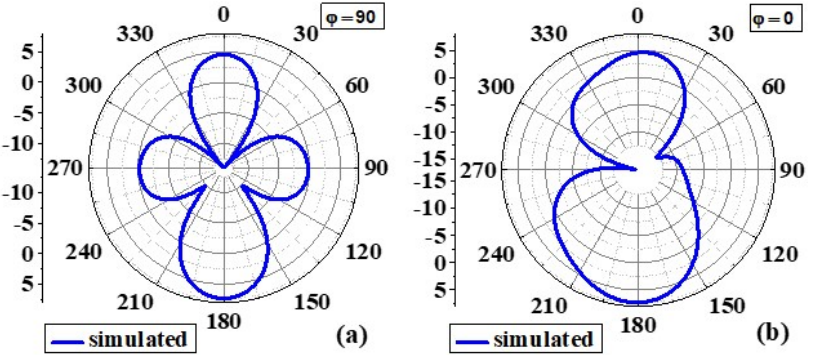
Figure 8. Simulated 2D radiation pattern of the proposed antenna without AMC at 8.6GHz: ( a ) ϕ = 90 and ( b ) ϕ = 0.